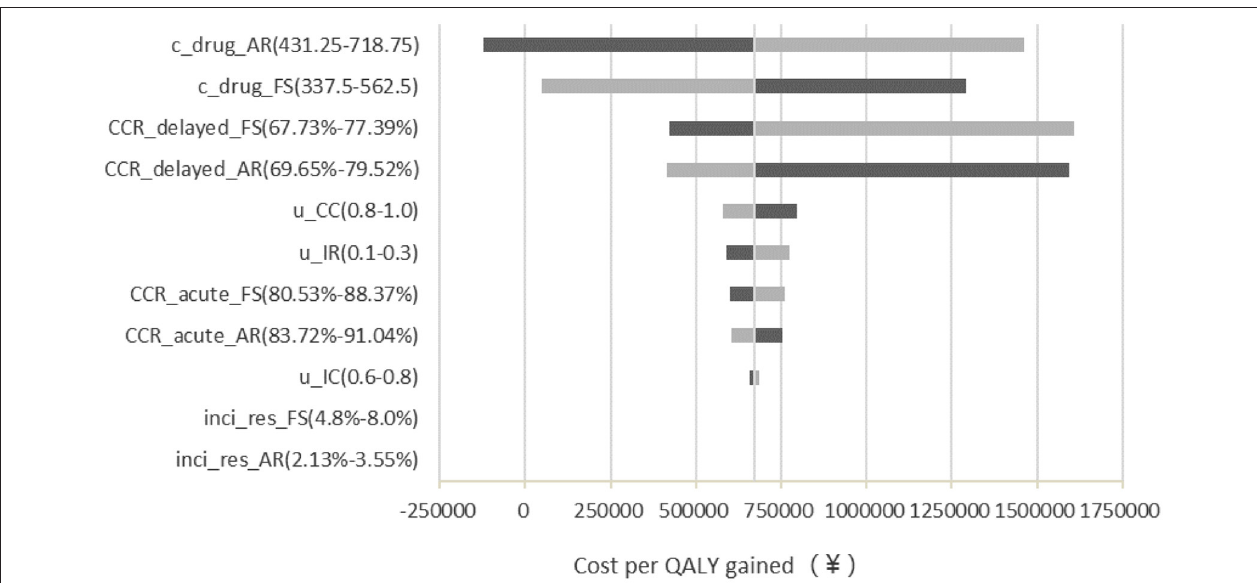
FIGURE 2 | Deterministic sensitivity analysis tornado diagram of FosAPR vs. APR in CEA. c, cost; CCR, complete control ratio; u, utility; FS, fosaprepitant; AR, aprepitant; inci_res, incidence of rescue therapy.